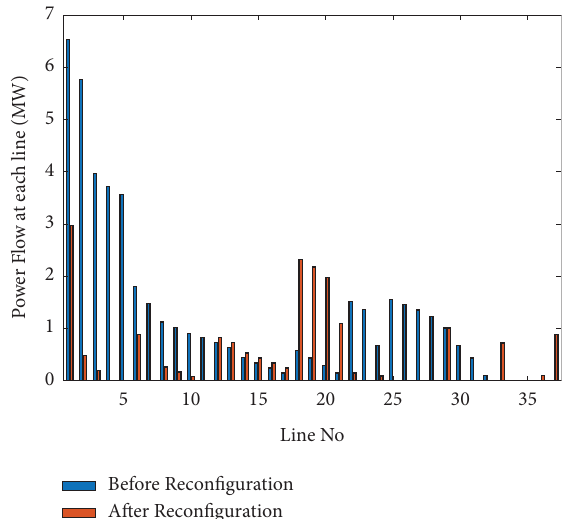
Figure 11: Power fow at each line in 33-bus system heavy load before and after reconfguration.